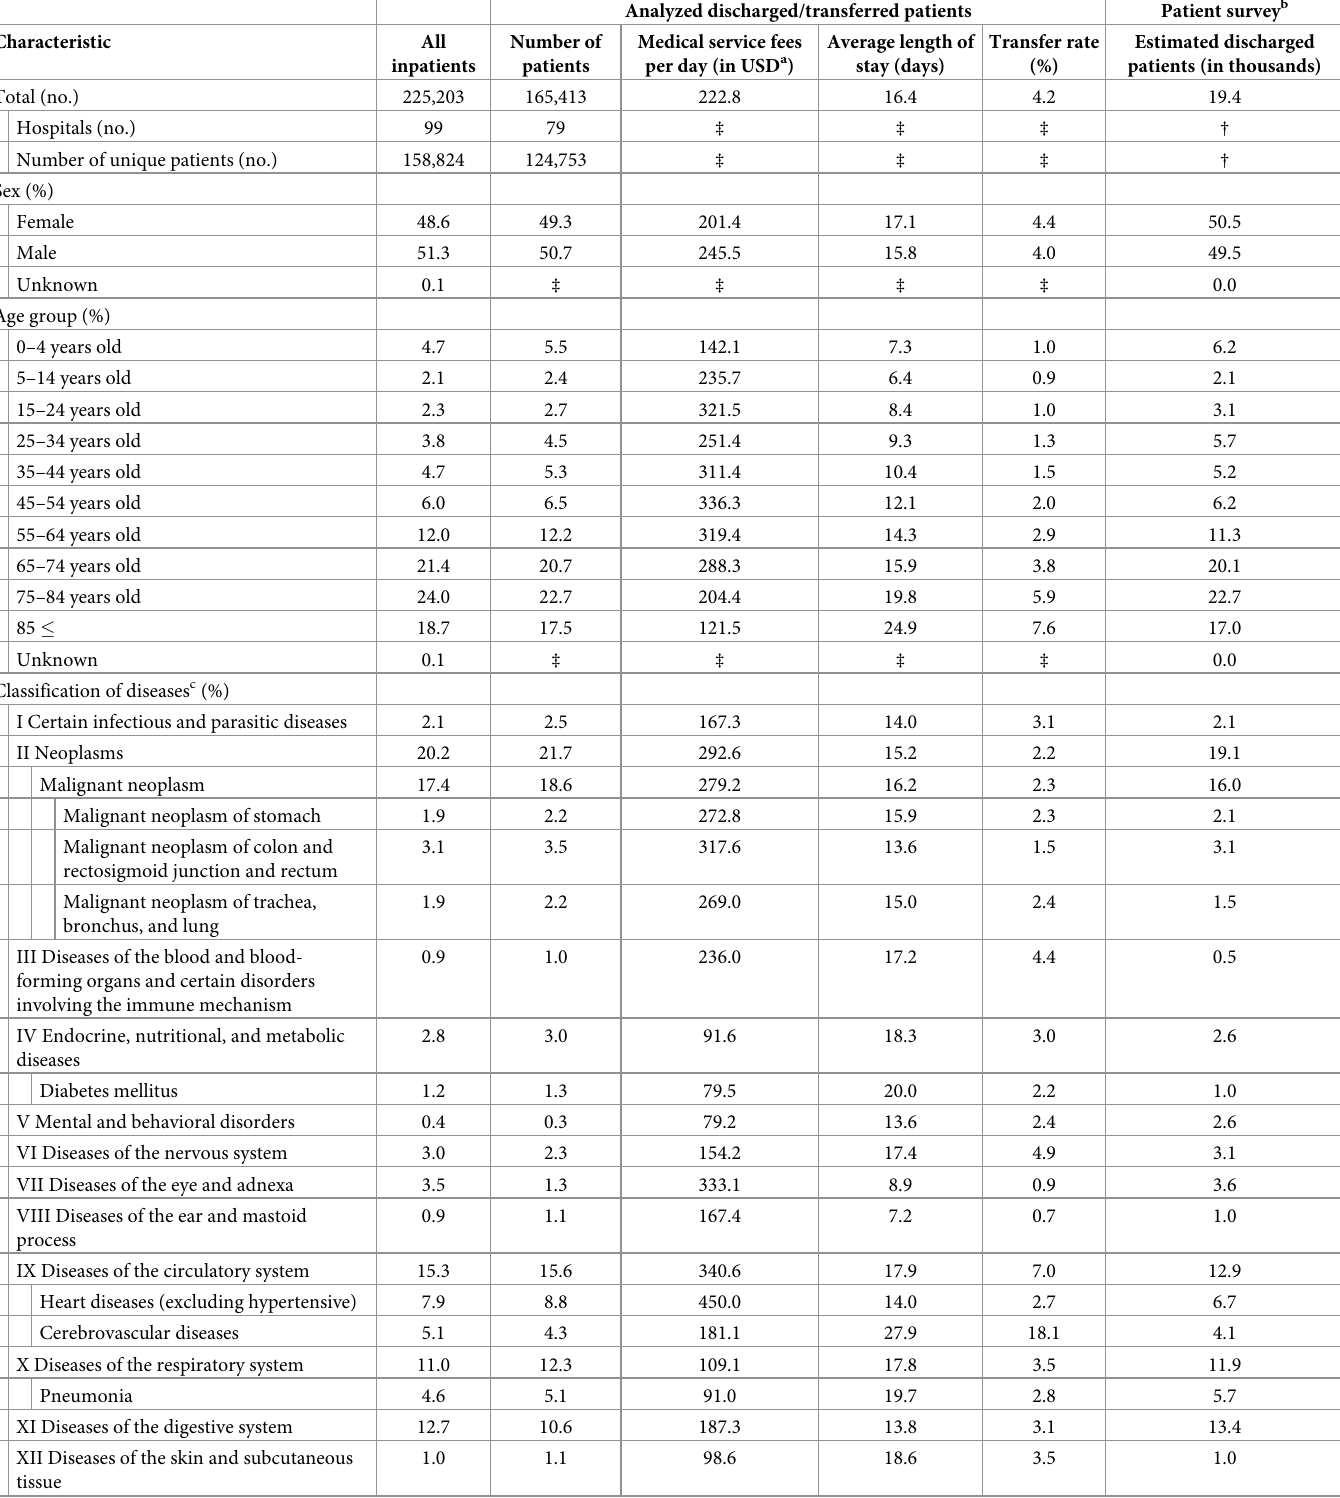
Table 1. Characteristics of patients and medical